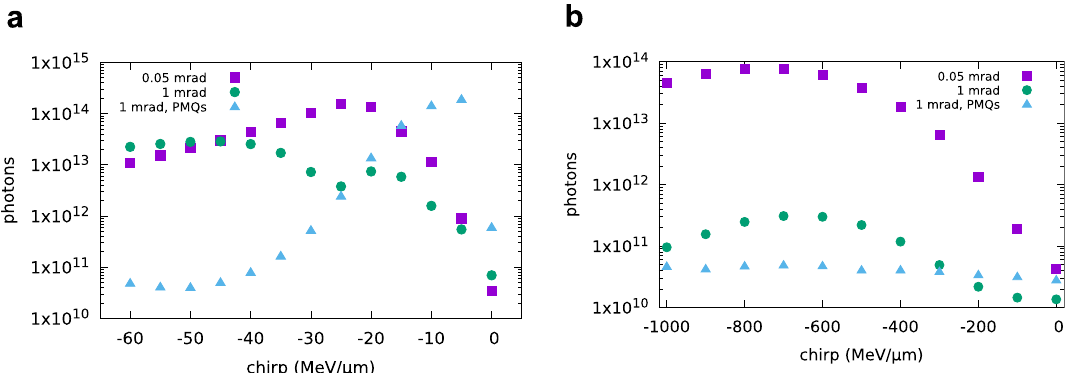
Figure 7. Undulator radiation obtained using GPT including space-charge effects for an electron beam with varying divergence, 1 π mm mrad normalized emittance, 0.1% slice energy spread, 100 pC charge and ( a ) 100 MeV energy and 1 fs initial r.m.s. bunch duration ( b ) 250 MeV energy and 100 as initial r.m.s. bunch duration. Radiation is calculated 1 m from the undulator exit in a 10 mm × 10 mm